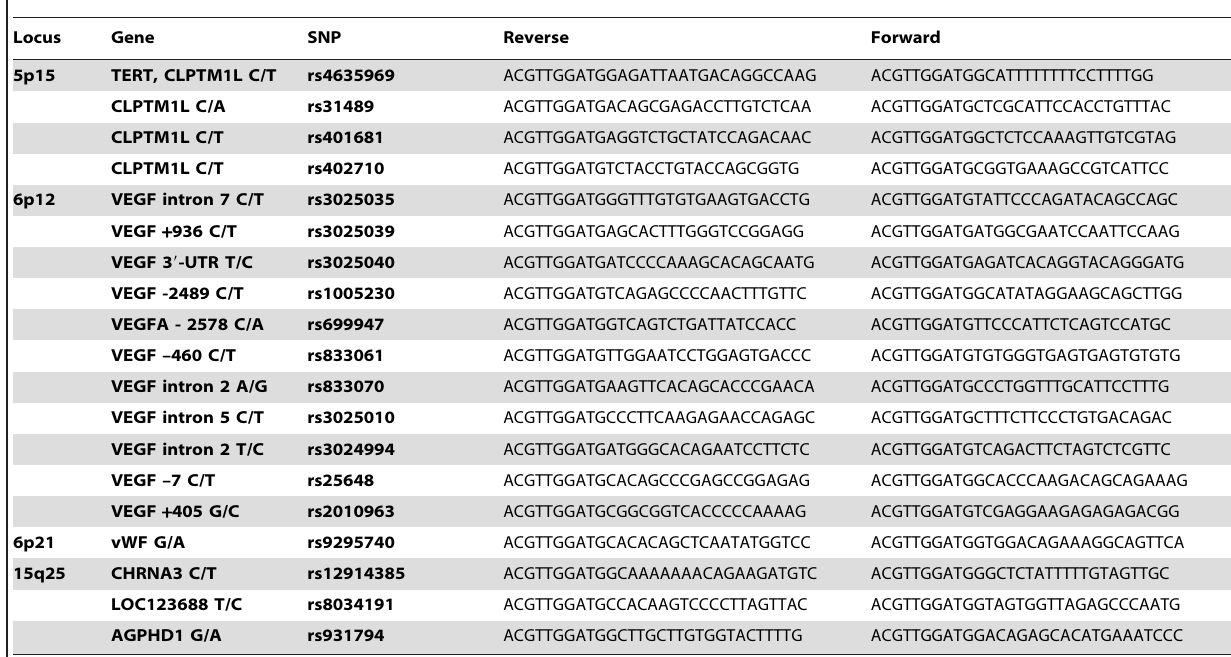
Table 1. Single nucleotide polymorphisms primers sequence of the study.